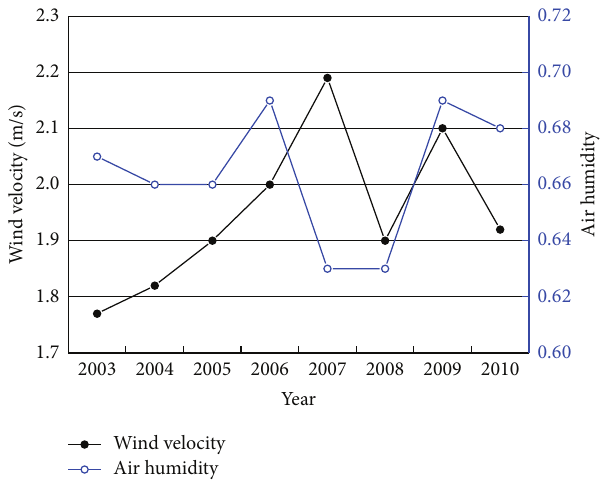
Figure 9: The variation trends of annual mean of 1-hour (13:10– 14:10) air humidity and wind velocity in Dongping Lake during 2003–2010 (open circle means air humidity, dot means wind veloc- ity).